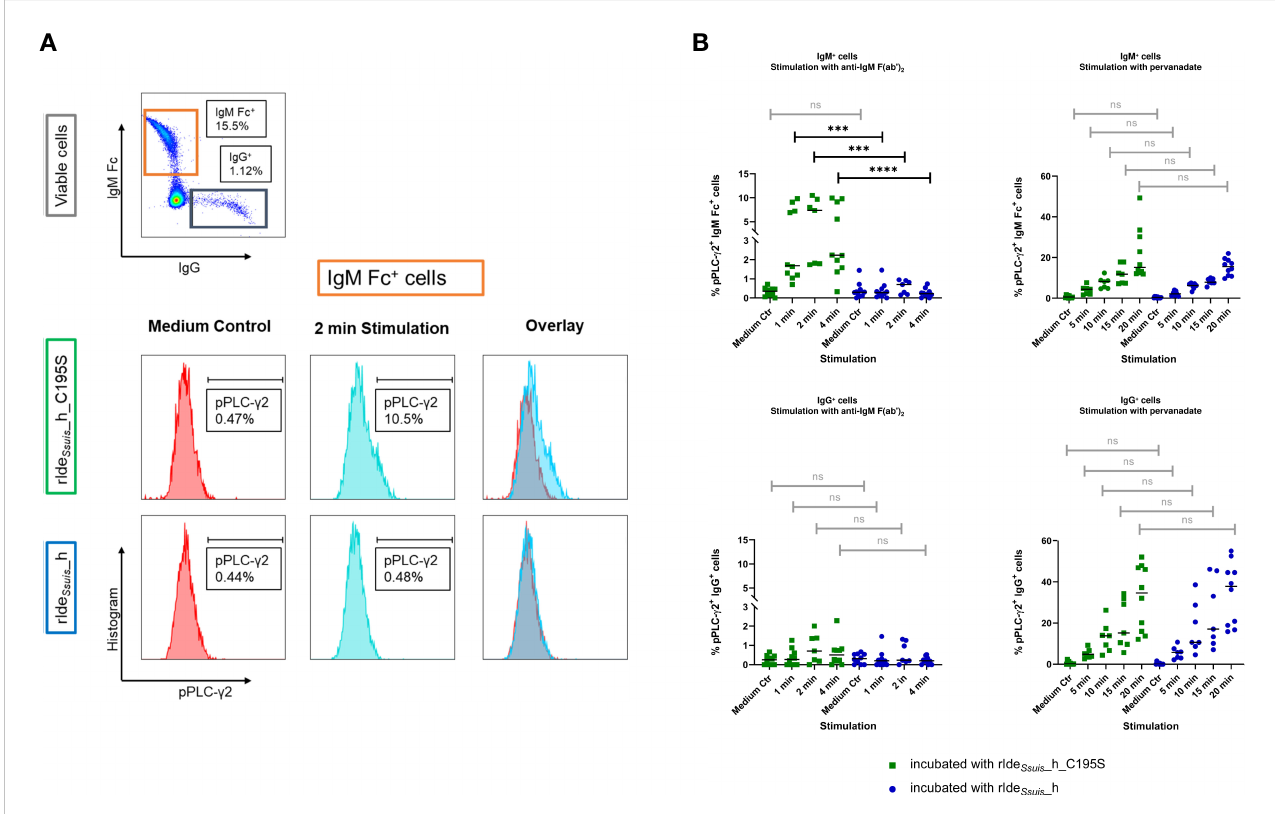
FIGURE 3 Treatment with rIde Ssuis _homologue abolishes IgM B cell receptor mediated signaling after IgM F(ab ’ ) 2 -speci fi c stimulation in IgM + , but not IgG + B cells. (A) Gating strategy to analyze IgM + and IgG + cells for phosphorylated phospholipase C- g 2 (pPLC- g 2) after treatment with rIde Ssuis _homologue (rIde Ssuis _h) or non-functional point-mutated rIde Ssuis _homologue_C195S (rIde Ssuis _h_C195S). Representative histograms of IgM Fc + cells are shown. Cells were kept in culture medium as control (lower panels, left hand side) or were stimulated with anti-IgM F(ab ’ ) 2 (lower panels, middle) and analyzed for the percentage of pPLC- g 2 + cells. (B) Stimulation with anti-IgM F(ab ’ ) 2 induces tyrosine phosphorylation of phospholipase C- g 2 (PLC- g 2) in IgM + , but not IgG + lymphocytes. “ After cleavage of the IgM BCR, there is no longer an increase in pPLC- g 2 + IgM + cells detectable. Both cell types can be stimulated with pervanadate, independent of BCR cleavage. Porcine PBMC of 7 to 8-week-old piglets (n = 10) were incubated for 45 min with 4 µg/ 1x10 6 cells rIde Ssuis _homologue (rIde Ssuis _h) or rIde Ssuis _homologue_C195S (rIde Ssuis _h_C195S). After washing, cells were stimulated with anti-IgM F(ab ’ ) 2 or tyrosine phosphatase inhibitor pervanadate for the indicated times. Cells were stained and analyzed for IgM Fc or IgG and phosphorylated PLC- g 2 + by fl ow cytometry. Same time points were compared with Mann-Whitney test. Bars represent median, signi fi cant differences are indicated (p > 0.5 ns, p < 0.001 ***, p < 0.0001